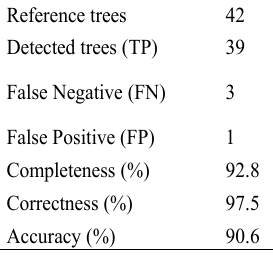
Table 2. Evaluation of automatic tree stems